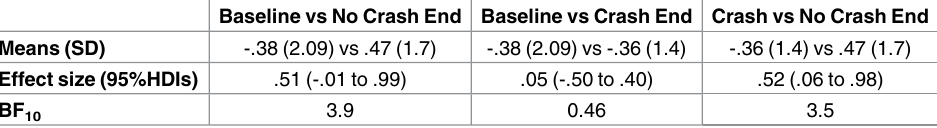
Table 3. Effect sizes with their corresponding 95% HDIs and BayesFactor values, of the comparisons between the three conditions using the channels emerged from the permutation